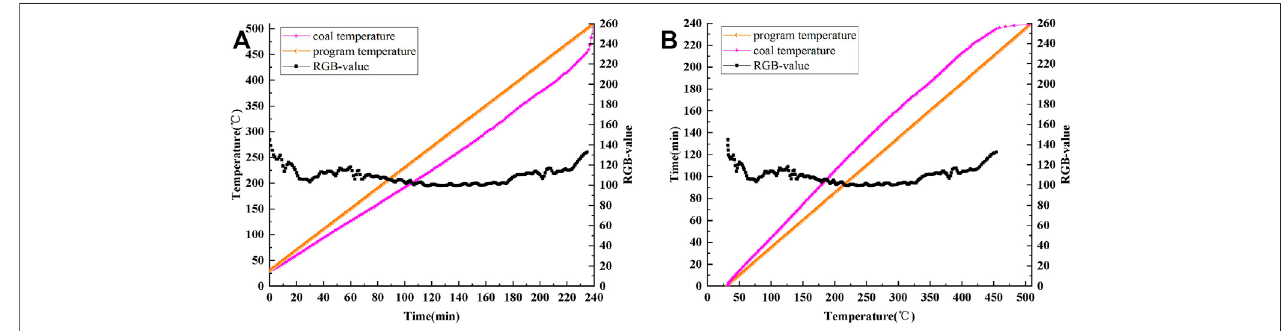
FIGURE 7 | Curves of program temperature, coal temperature and RGB-value: (A) time-varying, (B) temperature-varying.